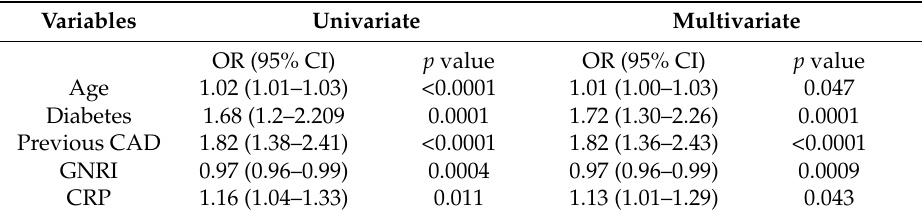
Table 2. Associated factors for abnormal ABI (<0.9 or >1.4).